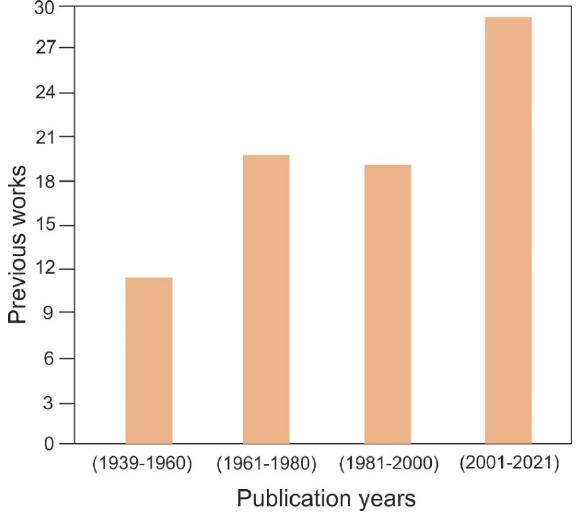
Figure 2. Number of previous research works included in this study versus publication years.